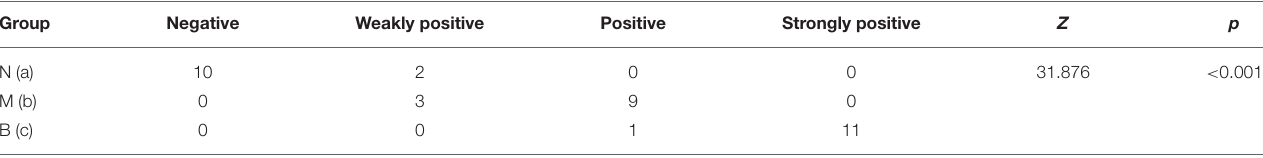
TABLE 3 | Comparison of IL-23 expression in three groups of mice epidermis. Group Negative Weakly positive